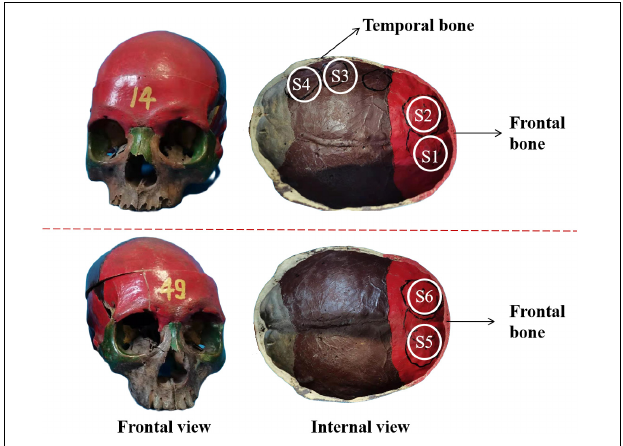
FIGURE 4 | The frontal view and internal view of the real skull. S1–S4 and S5, S6 are selected as the experimental test